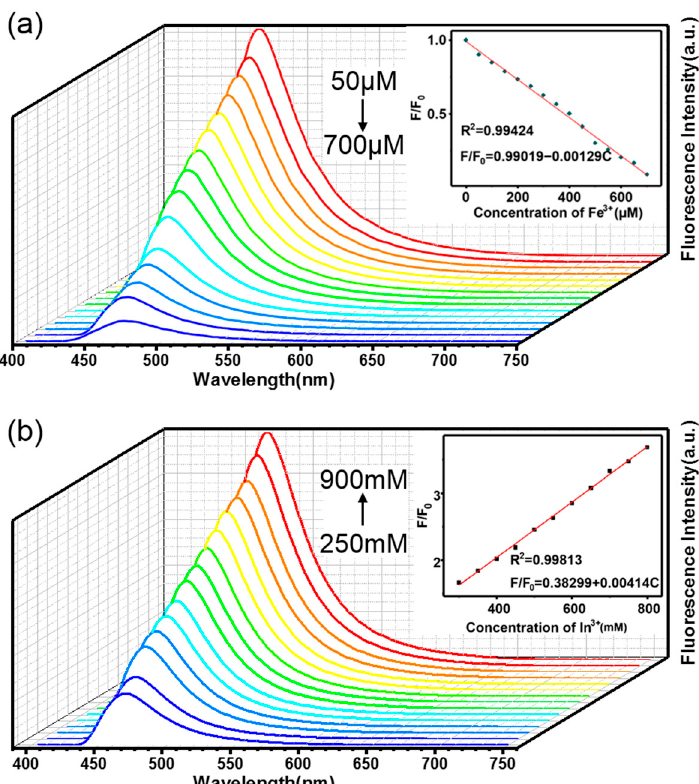
Figure 7. ( a ) Fluorescence intensity of CLS containing different concentrations of Fe 3+ solutions (inset: linear relationship of the fluorescence intensity and Fe 3+ concentration) and ( b ) fluorescence intensity of CLS with different concentration of In 3+ solutions (inset: linear relationship of the fluorescence intensity and In 3+ concentration).